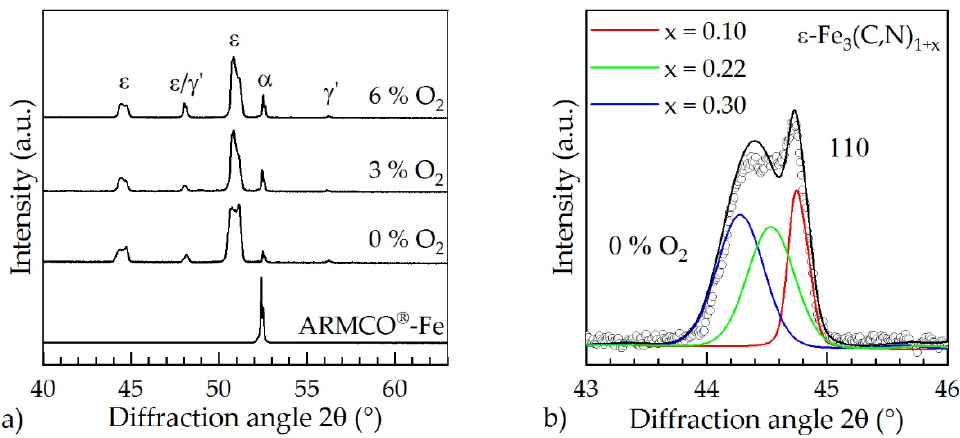
Figure 5. ( a ) X-ray diffraction patterns using Co-K α radiation; ( b ) peak analysis of the ε (110) peak at 0% oxygen. Values